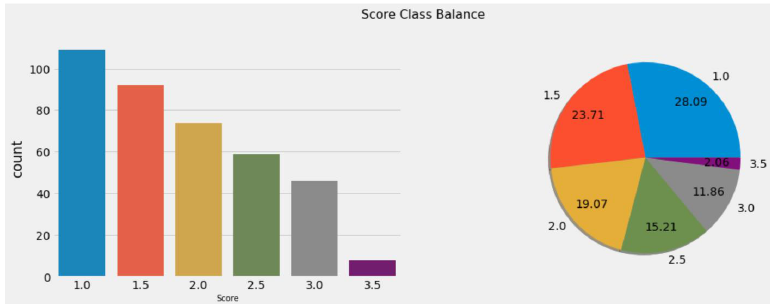
Figure 5. Distribution of the target class.